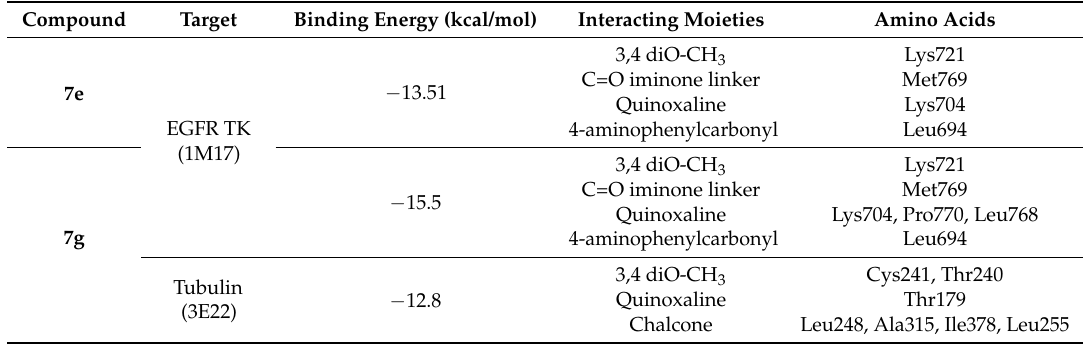
Table 3. Docking scores, amino acid interactions and interacting groups of the docked compounds into the active site of EGFR-TK and